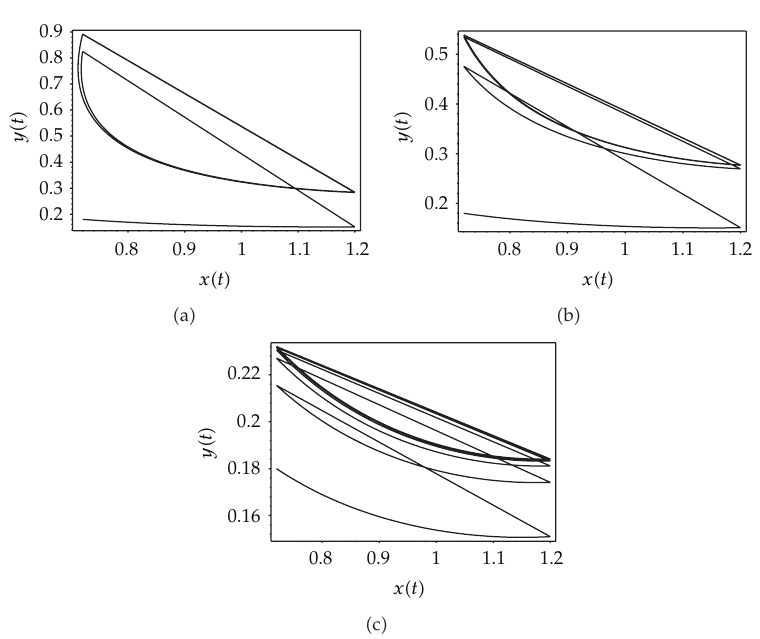
Figure 10: The phase portraits of system (cid:6) 1.3 (cid:7) with p (cid:8) 0 . 4, q (cid:8) 0 . 5, x 0 (cid:8) 0 . 72, y 0 (cid:8) 0 . 18 , h (cid:8) 1 . 2 < x ∗ , and di ff erent ι : (cid:6) a (cid:7) ι (cid:8) 0 . 75; (cid:6) b (cid:7) ι (cid:8) 0 . 4; (cid:6) c (cid:7) ι (cid:8) 0 . 14.